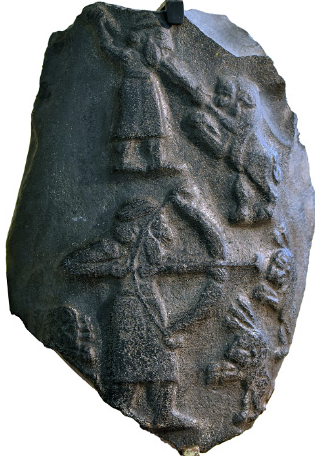
Figure 12. Lion hunt scene (IrMus inv. no. IM 23.477); basalt relief; Uruk, Southern Mesopotamia (mod. Iraq); Jemdet Nasr period, ca. 4th mill. BCE [photography by Osama Shukir Muhammed Amin; courtesy of the Ancient History Encyclopedia].